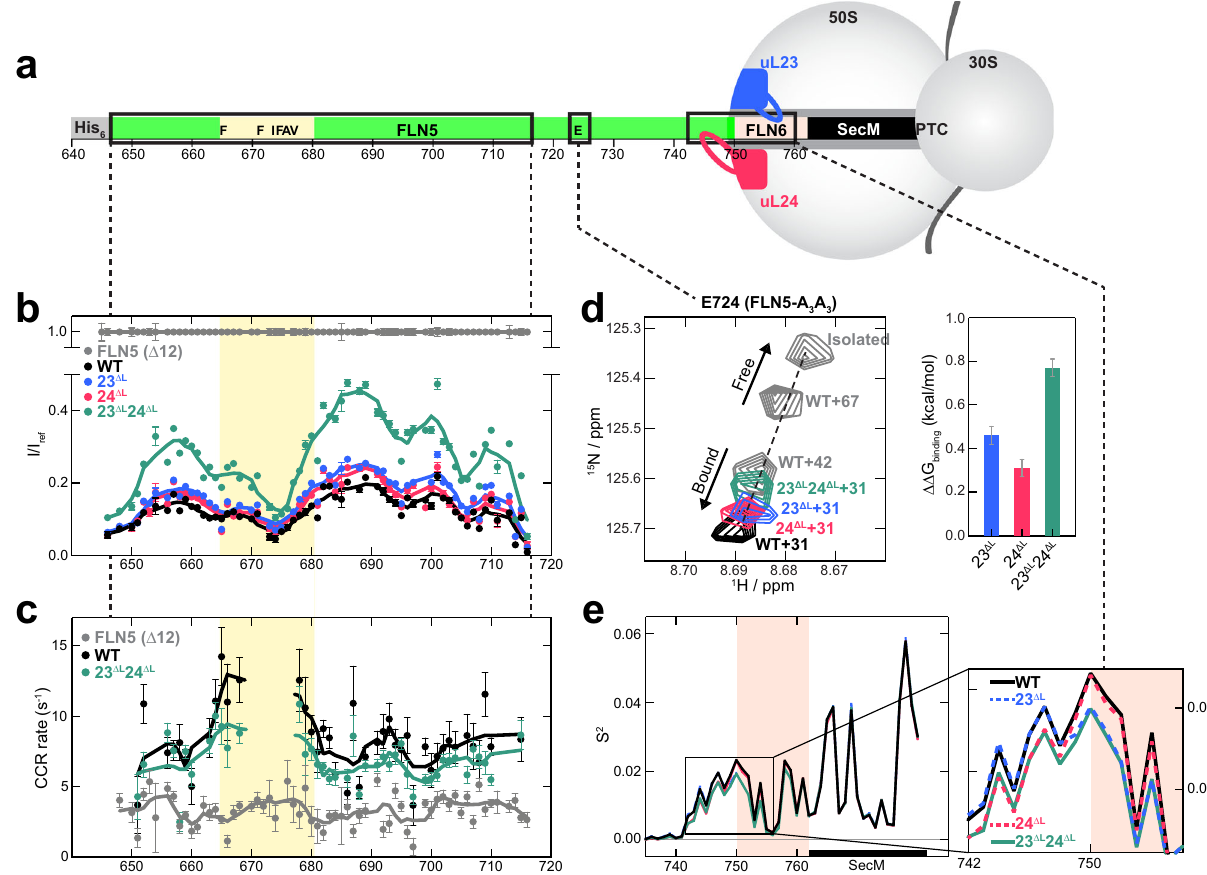
Fig. 4 Modulation of the interaction between unfolded nascent chains and the ribosome by uL23 and uL24 loop truncation. a Schematic of the WT + 31 RNC ( L = 31) with sequence and domain landmarks indicated. Three regions of the NC whose dynamics was monitored by NMR and all-atom MD simulations (residues 648 – 717, 724 and 735 – 758) are shown in black rectangles. b Relative intensities (I) of 1 H- 15 N cross-peaks from the spectra of an isolated unfolded FLN5 Δ 12 (grey circles, I ref ), WT + 21 (black circles), 23 Δ L + 21(blue circles), 24 Δ L + 21(red circles) and 23 Δ L 24 Δ L + 21 (turquoise circles) RNCs. A four-point moving average is plotted as a guide. Yellow-shaded region indicates the residues that interact with ribosomal outer surface. Errors are derived from spectral noise from a single measurement. c Cross-correlated relaxation rates of FLN5 Δ 12, WT + 21 and 23 Δ L 24 Δ L + 21. A four- point moving average is plotted as a guide. Errors are derived from the spectral noise for FLN5 Δ 12 and WT, while the mean and standard error from two biological repeats are shown for 23 Δ L 24 Δ L . d 1 H- 15 N cross-peaks of E724 of the A 3 A 3 variant of FLN5 of the WT ( L = 31, 42 and 67) and 23 Δ L , 24 Δ L , 23 Δ L 24 Δ L ( L = 31) RNCs with that of the isolated unfolded protein. All spectra are recorded at a 1 H frequency of 950 MHz. The changes in the free energy of binding ( ΔΔ G binding ) in 23 Δ L , 24 Δ L and 23 Δ L 24 Δ L RNCs are calculated using the populations of unbound state NC (P_Ub, Supplementary Fig. 10b). Errors are s.d. and calculated by propagating the s.d. of P_Ub. e S 2 order parameters determined from simulated ensembles of the unfolded NCs on WT, 23 Δ L , 24 Δ L and 23 Δ L 24 Δ L RNCs ( L = 31). The salmon pink-shaded region indicates the FLN6 linker residues between FLN5 and